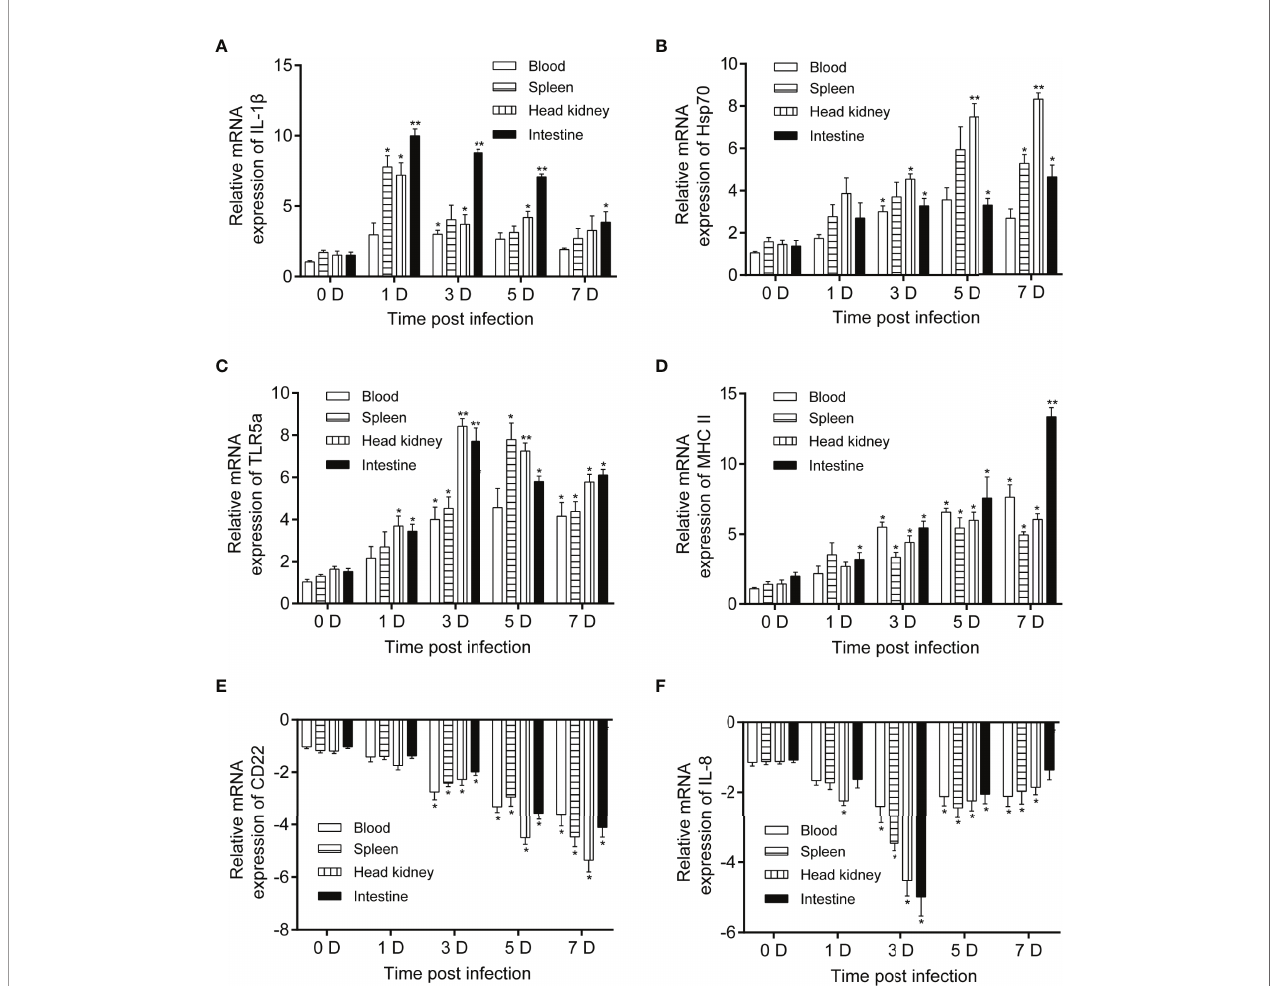
FIGURE 7 | Relative mRNA expression levels of IL-1 b , Hsp70, TLR5a, MCH II, CD22, and IL-8 in C carpio tissues after P. shigelloides challenge. mRNA expression levels of IL-1 b (A) , Hsp70 (B) , TLR5a (C) , MCH II (D) , CD22 (E) , and IL-8 (F) in the blood, spleen, head kidney, and intestine of C carpio at 0, 1, 3, 5, and 7 days after P. shigelloides challenge. The b -actin gene was used as a reference gene, and the data of day 0 were used for comparison with those of days 1, 3, 5, and 7 in order to analyze the differences. Data are presented as the means ± SEs (n = 4). Statistical analysis was performed using unpaired Student ’ s t-test (* P < 0.05 and ** P <